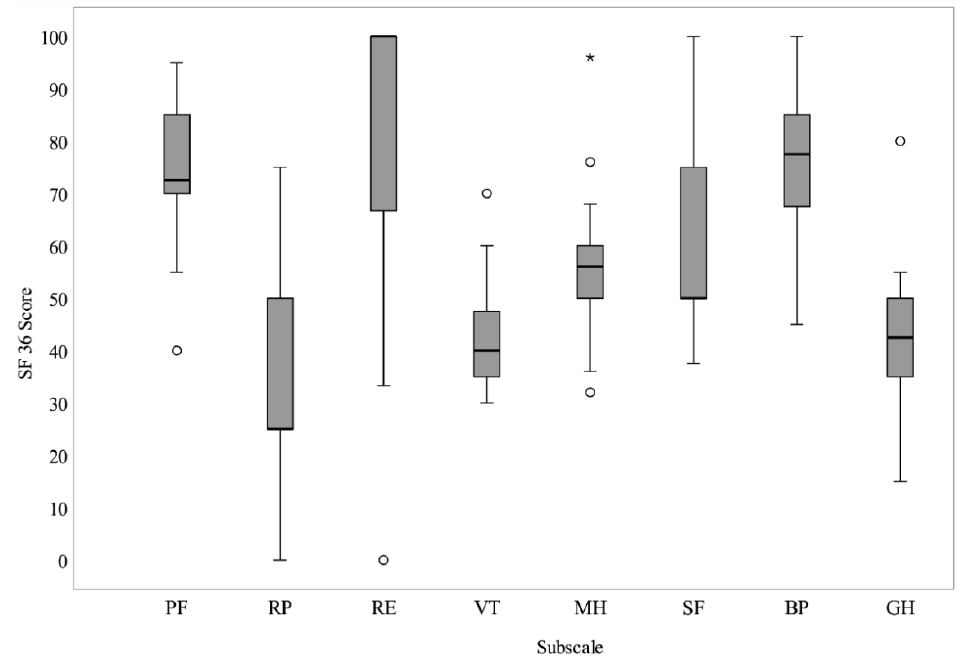
Figure 2. SF-36 results showing the quality-of-life outcome approximately one year (10–14 months) after reconstruction with the TDAP-Scap-aa free flap. Subscales are Physical Functioning (PF), Role Physical (RP), Role Emotional (RE), Vitality (VT), Mental Health (MH), Social Functioning (SF), Bodily Pain (BP) and General Health (GH). * = extreme outlier; ◦ = mild outlier. Table 2. Summary data of the SF-36 quality-of-life results.